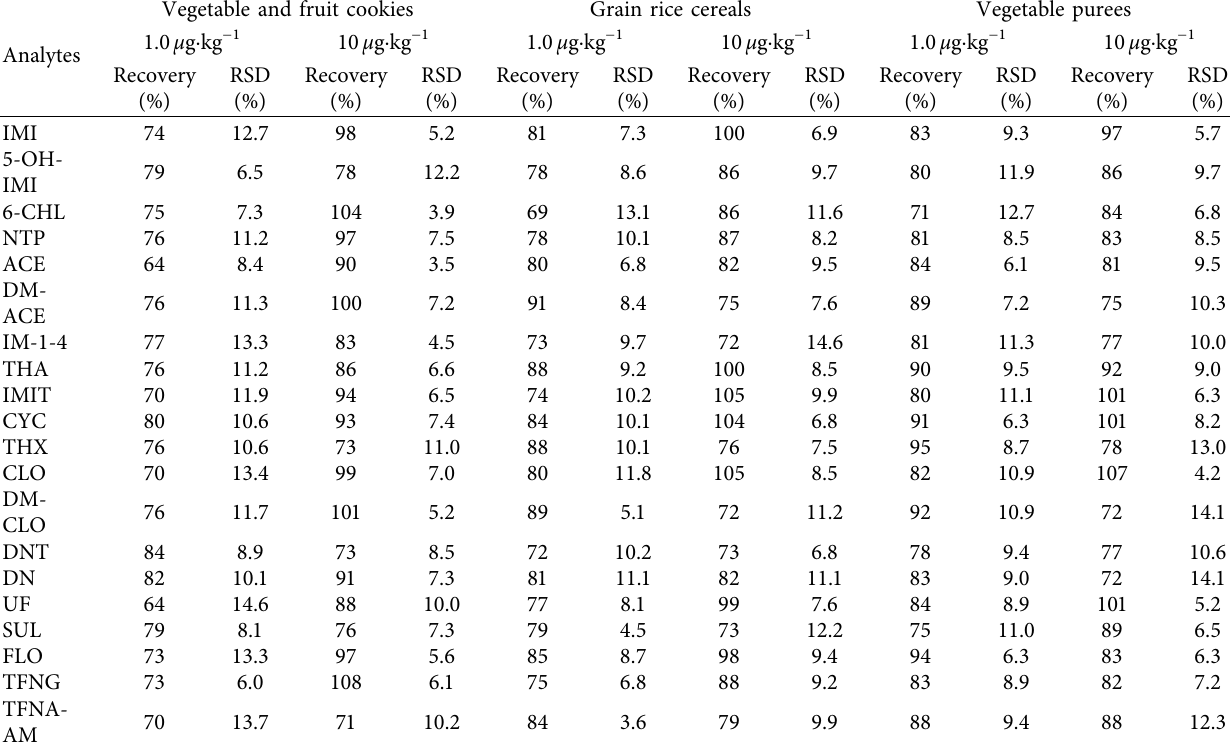
Table 2: Recovery rates of all target compounds spiked in three different matrices at two different concentrations (intraday n � 6). Vegetable and fruit cookies Grain rice cereals Vegetable purees Analytes